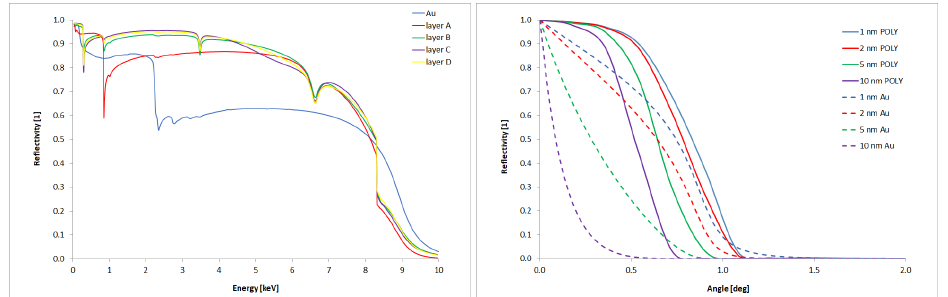
Figure 6. Reflectivity dependence on incident photon energy for different multilayers at RMS = 2 nm ( left ). Reflectivity at incident angle of POLY and gold layers for diffrent RMS, 4.5 keV ( right ). POLY—nonperiodic multilayer on Au basis.